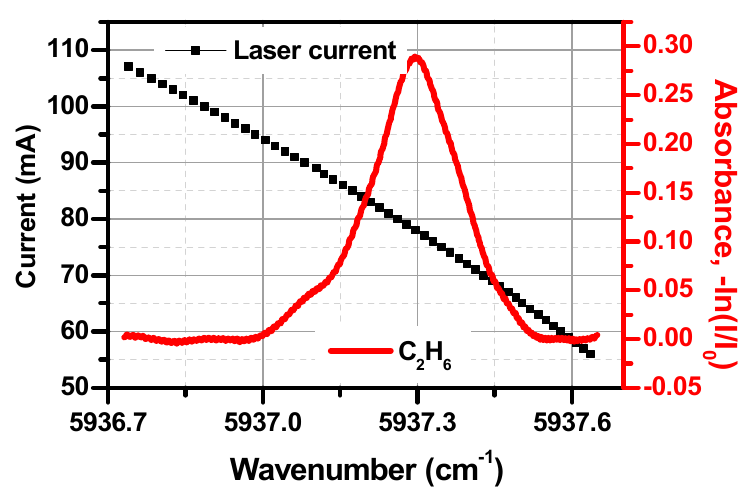
Figure 3. Absorption spectrum of ethane near 5937.3 cm − 1 . Left axis: laser current (vs. laser frequency); Right axis: absorbance of ethane in the tuning wavelength range.